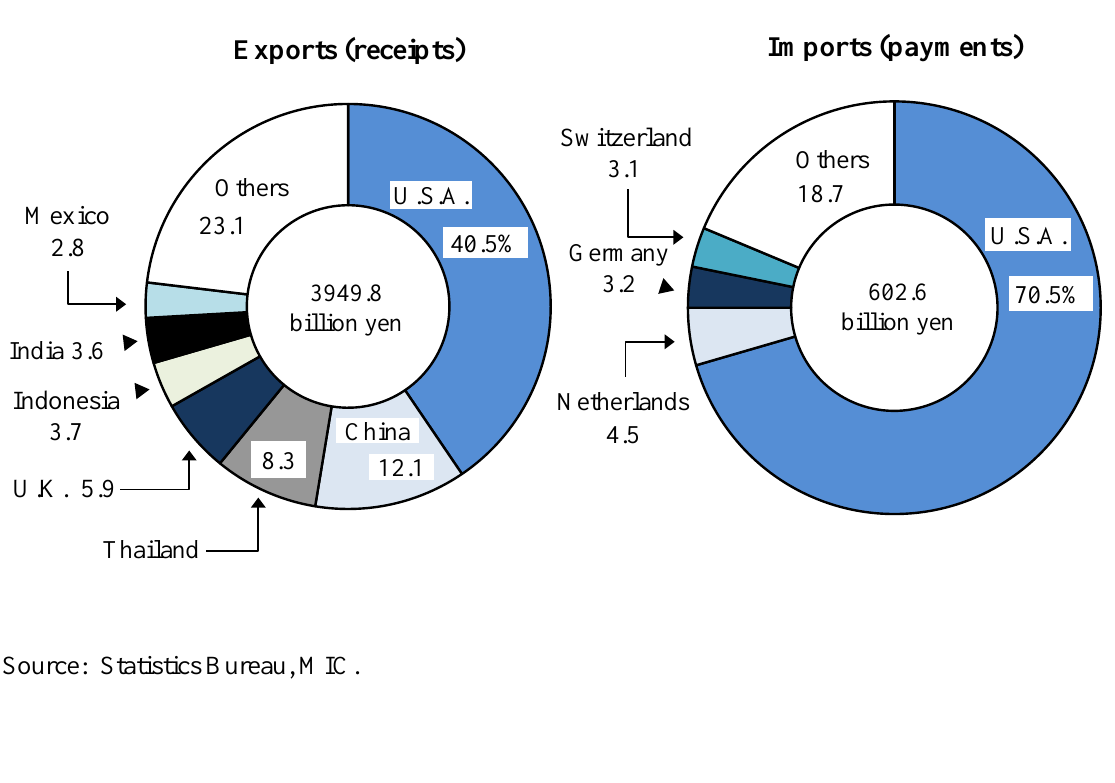
Figure 8.2 Composition of Technology Trade by Major Country/Region